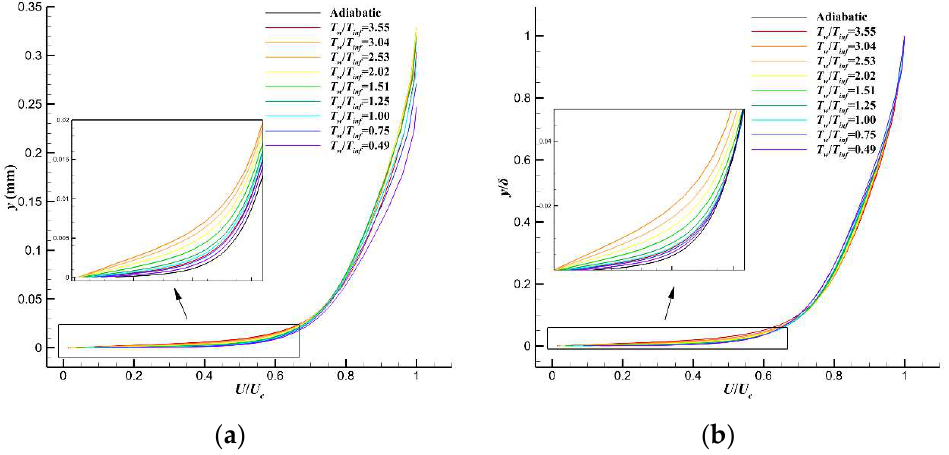
Figure 17. Velocity profiles of turbulent boundary layers. ( a ) U/Ue v.s. y ; ( b ) U/Ue v.s. y/δ .